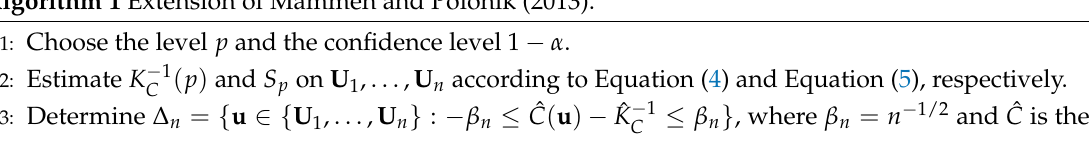
Algorithm 1 Extension of Mammen and Polonik